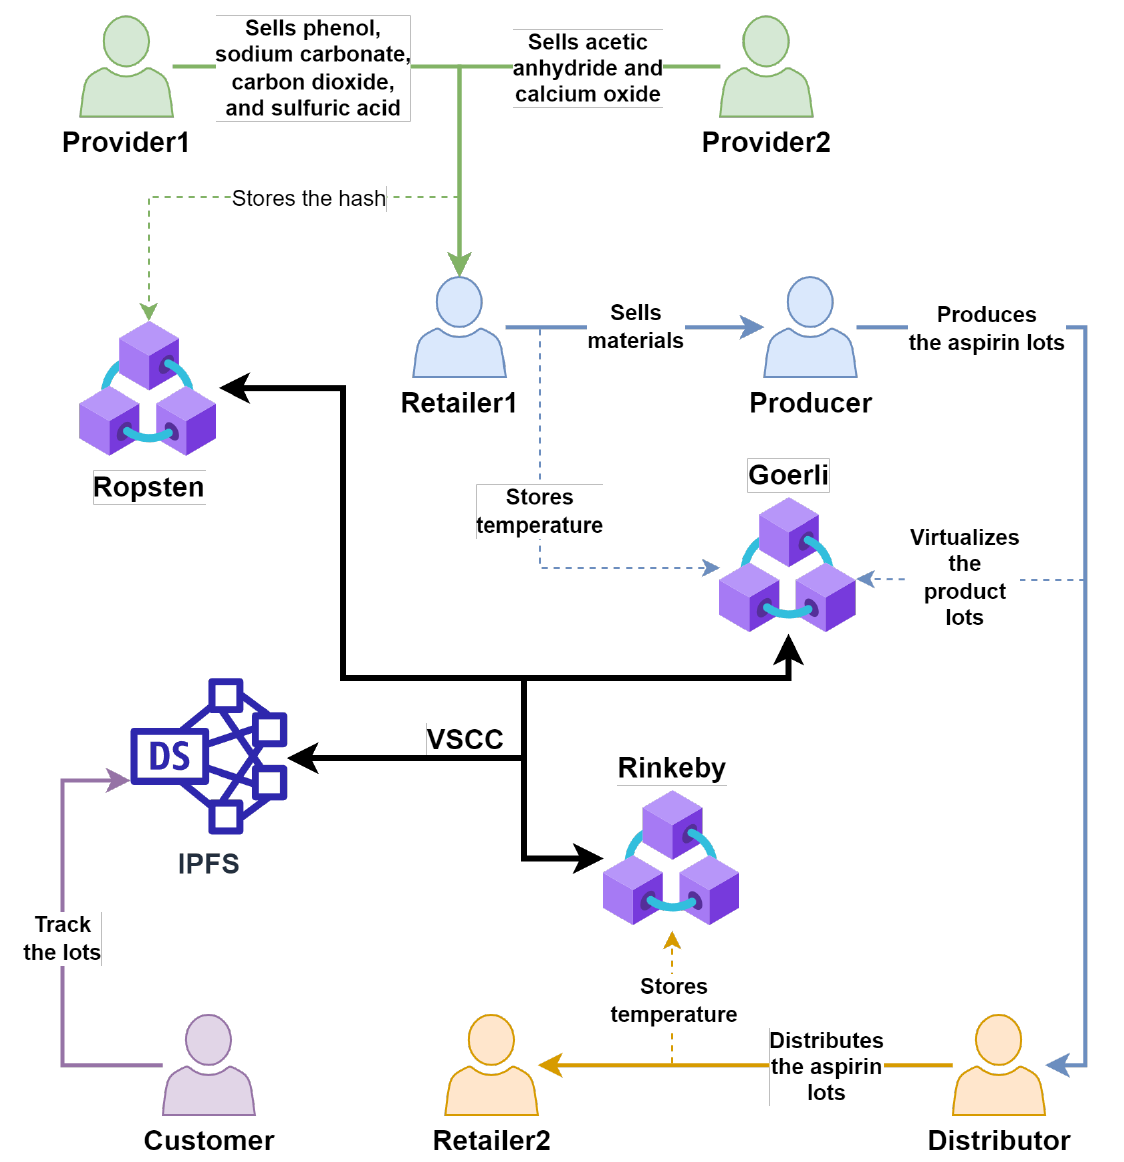
Figure 3. Diagram of the simulation carried out in a pharmaceutical blockchain-based supply chain scenario. It is shown how the different stakeholders are grouped together when they are part of the same platform (exemplified as the usage of different blockchain networks during the simulation). In the diagram it is possible to see how each stakeholder interacts with its own blockchain and how each blockchain is related through the VSCCs to the IPFS. Finally, the relationships between the stakeholders and the consumer during the tracking process are